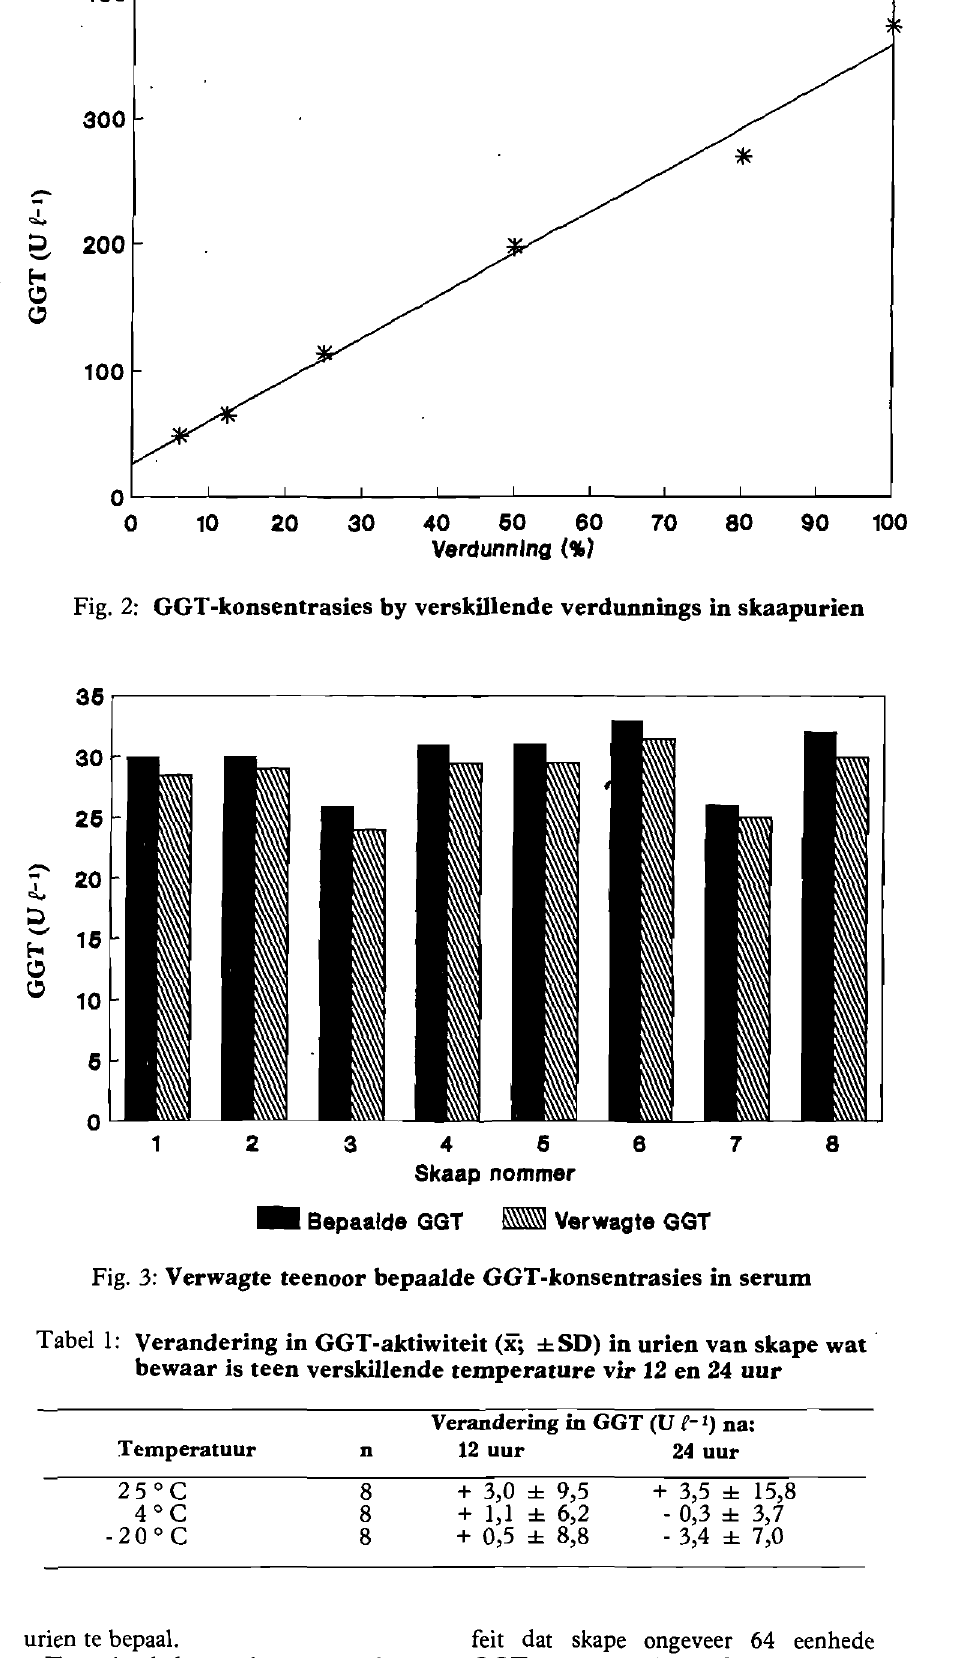
weefsel in die perd 3• Die gebruik van die uGGT/uCr ver houding om die relatiewe verHes van GGT in urien op 'n gerieflike manier te bepaal, is eers onlangs in die literatuur voorgestel l 7. Bayley et aJ.2 het serum